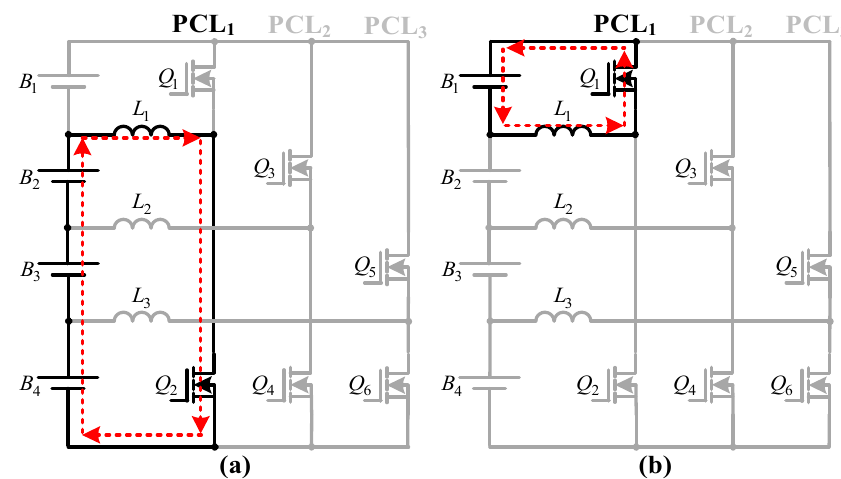
Figure 4. Operation of sub-pack-to-cell (SP2C) mode: ( a ) EC of subinterval 1, ( b ) EC of subinterval 2. Figure 4. Operation of sub-pack-to-sub-pack (SP2SP) mode: ( a ) EC of subinterval 1, ( b ) EC of subinterval 2.